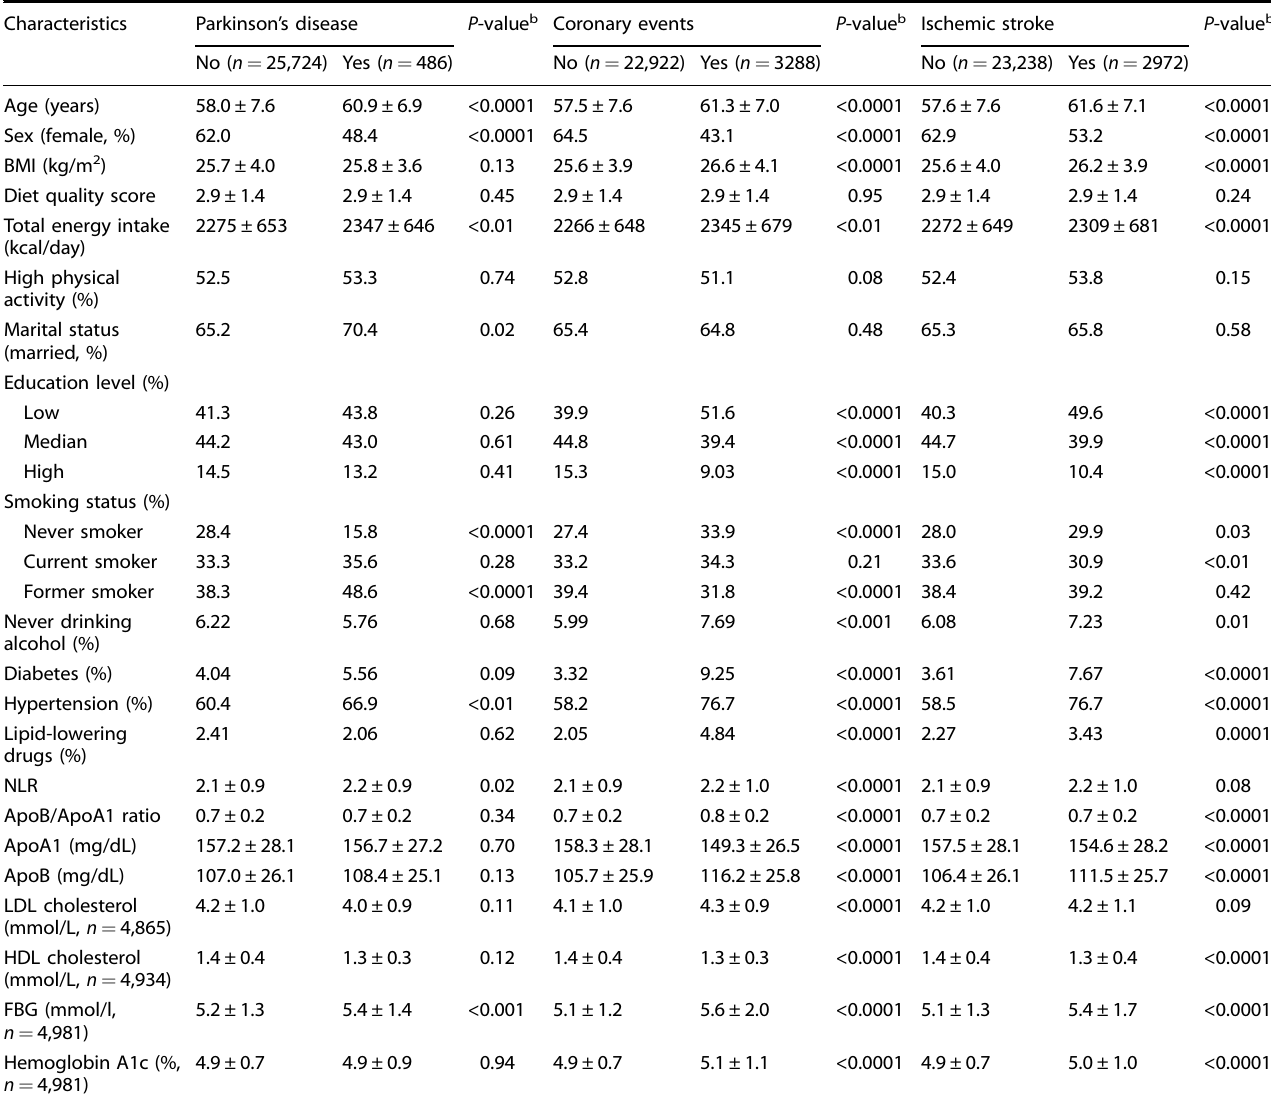
Table 1. Baseline characteristics of the study participants by incident disease status ( n = 26,210) a .